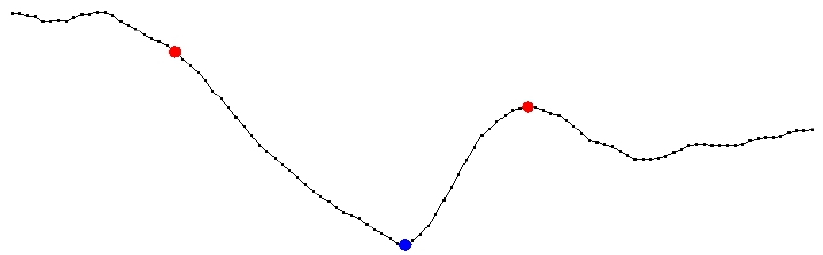
Figure 13. Automatic detection of the left and right bank.